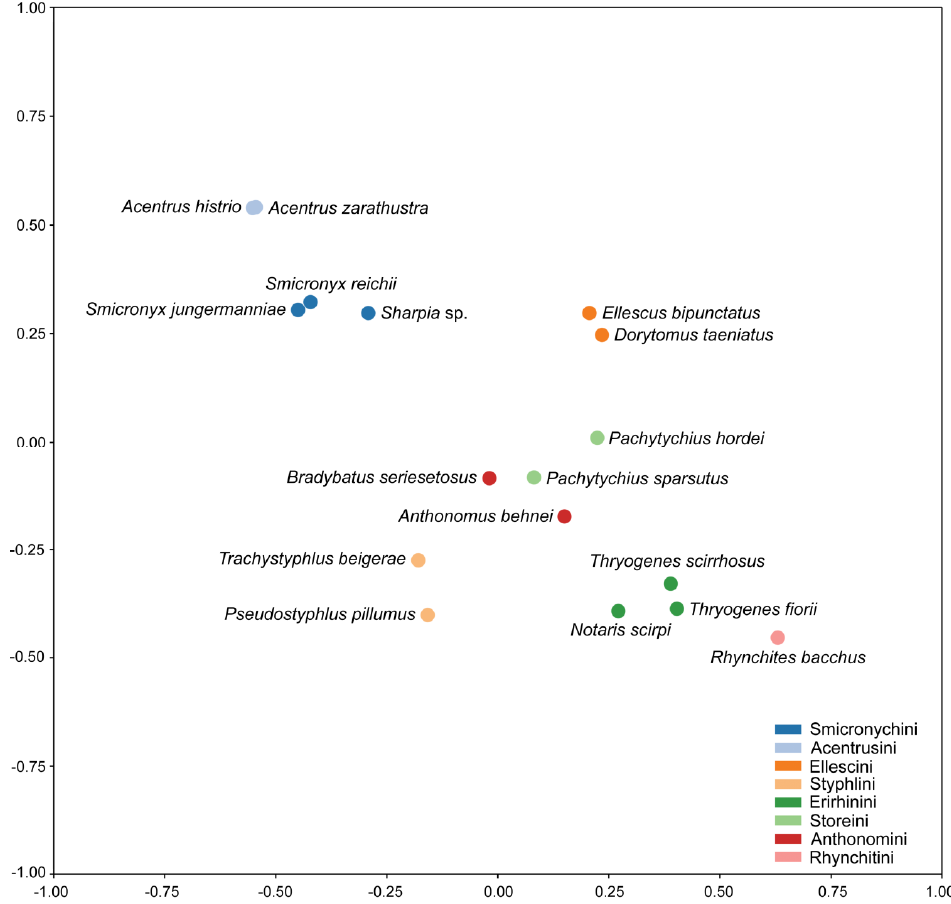
Figure 6. Nonmetric multi-dimensional scaling of 16 species belonging to seven tribes of the family Curculionidae and one outgroup species ( Rhynchites bacchus ). The ordination diagram was constructed from 32 characters, using the scikit-learn package in Python.